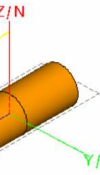
Figure 4. Geometry of a cylinder.